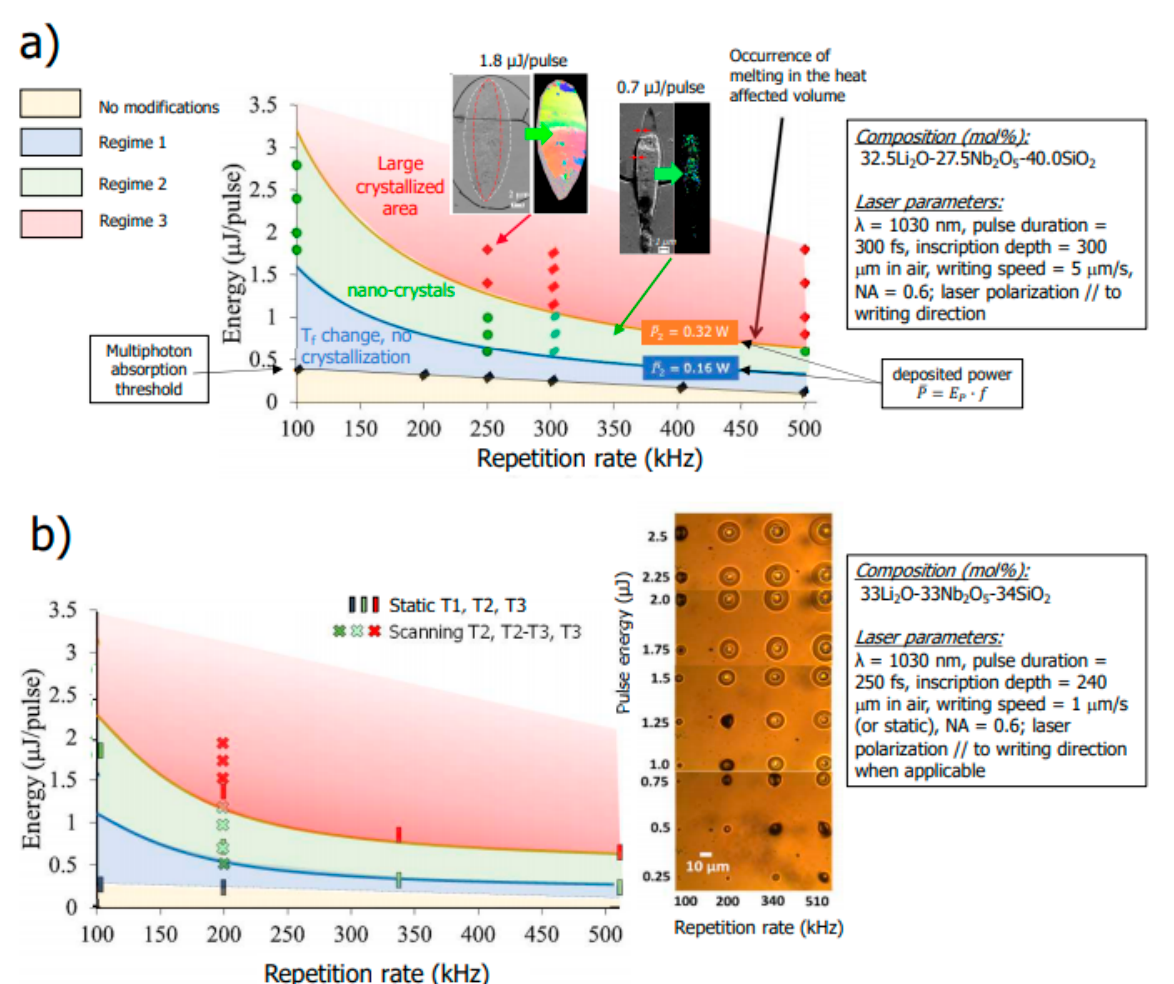
Figure 2. ( a ) The three regimes of laser induced modifications in the pulse energy—repetition rate plane (E p –f). The scheme on the left is for a LNS glass with a close composition than the one used in this paper ([12]). ( b ) Regimes established from results obtained with the glass composition and pulse duration used in the present paper. We note that the energy thresholds are a bit lower for the LNSB glass. N.B., the mention “static” means no beam scanning (dot production, the relevant parameter is the duration of irradiation) contrarily to “scanning” (the relevant parameter is the scanning speed).